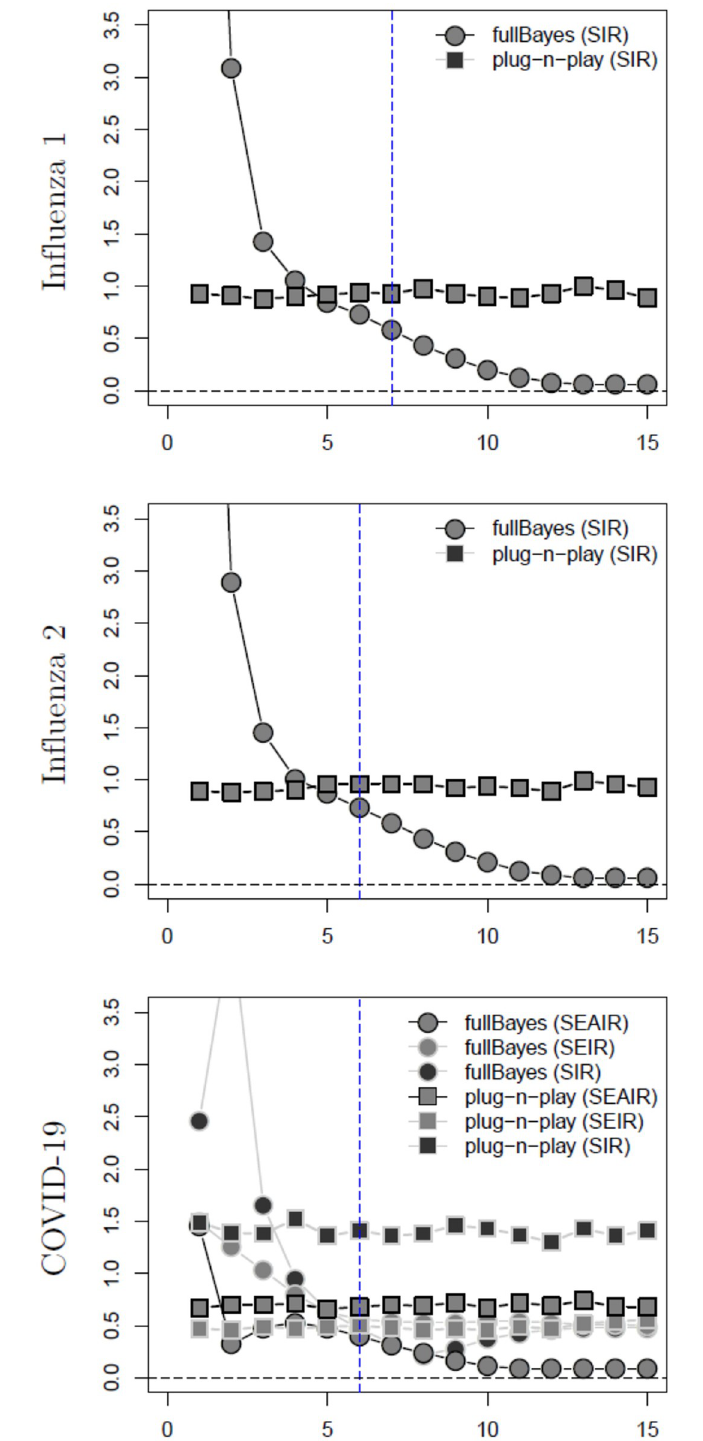
Fig 5. Estimated MSE of R 0 estimators assuming unknown serial interval (SI) (week on x -axis). For both influenza examples the data is SIR while for the COVID-19 example the data is SEAIR. The inflection point indicated by the blue dashed vertical